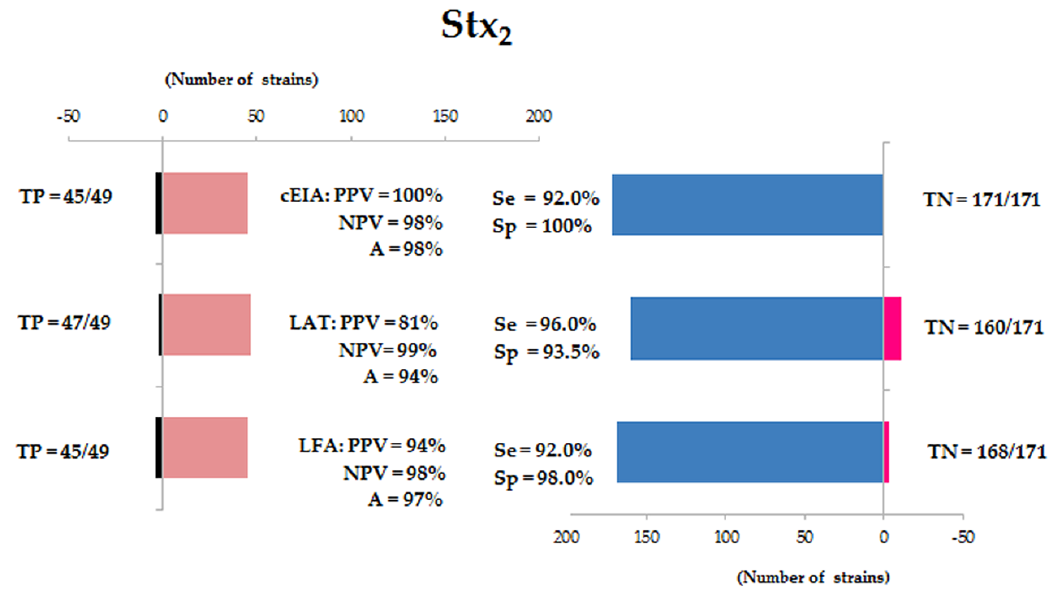
Figure 2. Analysis of Stx 2 detection by capture ELISA (cEIA), latex agglutination test (LAT) and lateral flow assay (LFA). TP = true positive strains; TN = true negative strains; PPV = predictive positive value; NPV = negative predictive value; A = accuracy; Se = sensitivity and Sp = specificity.